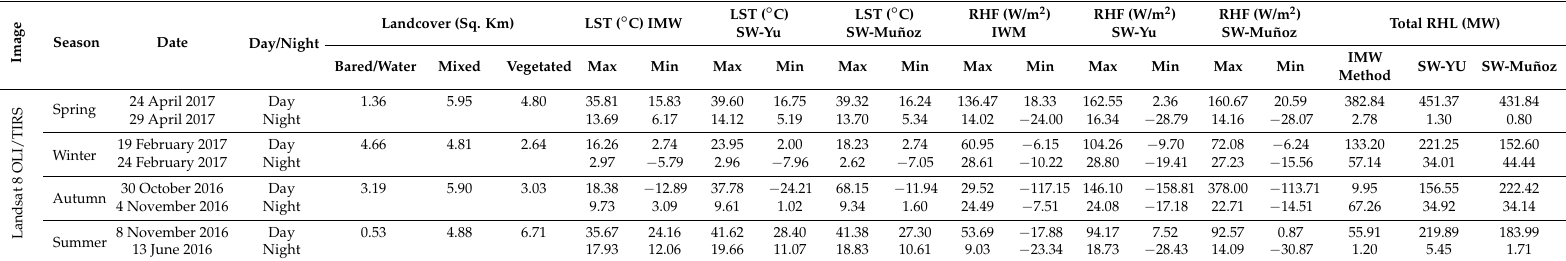
Table 6. Seasonal variation in both the daytime and nighttime estimates of heat loss within the Hatchobaru–Otake geothermal area, based on three different methods of land surface temperature estimation from the Landsat 8 OLI/TIRS